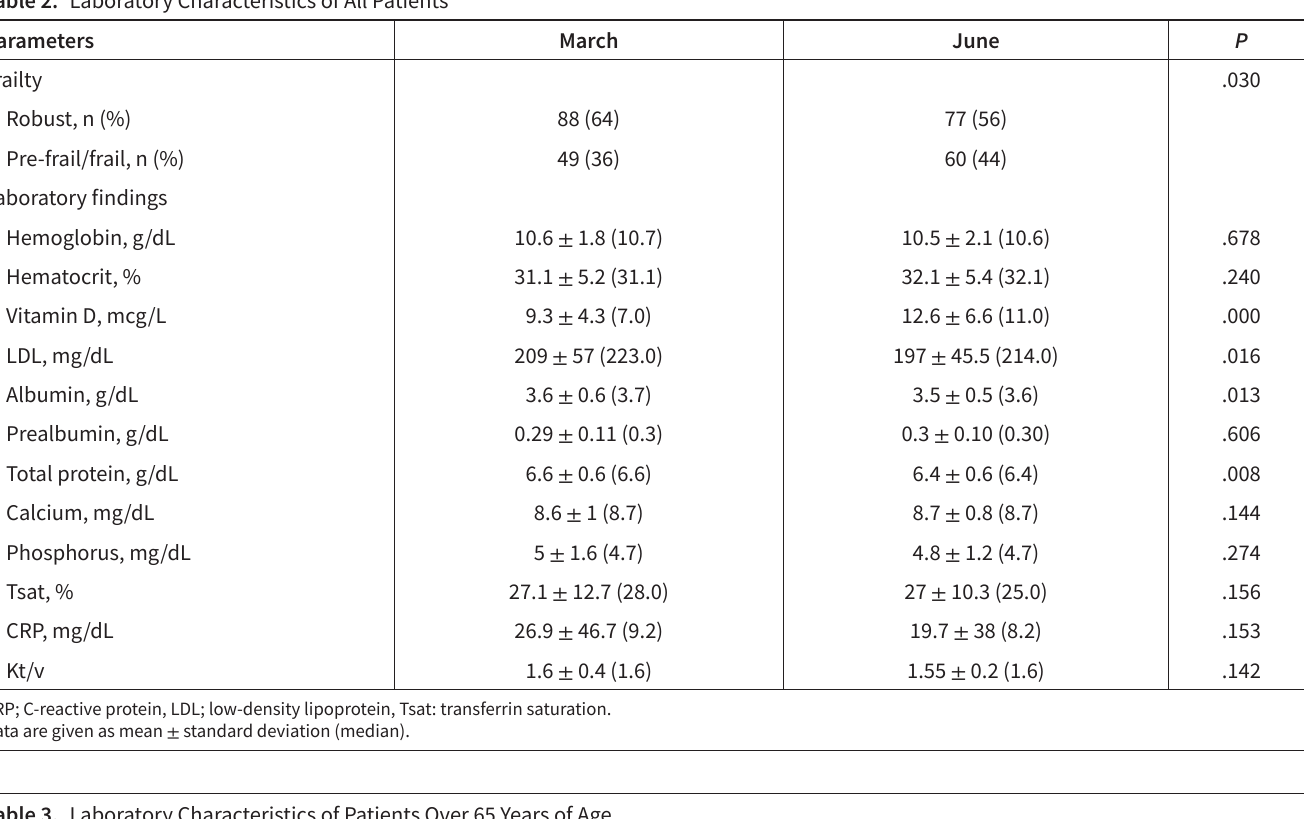
Table 3. Laboratory Characteristics of Patients Over 65 Years of Age